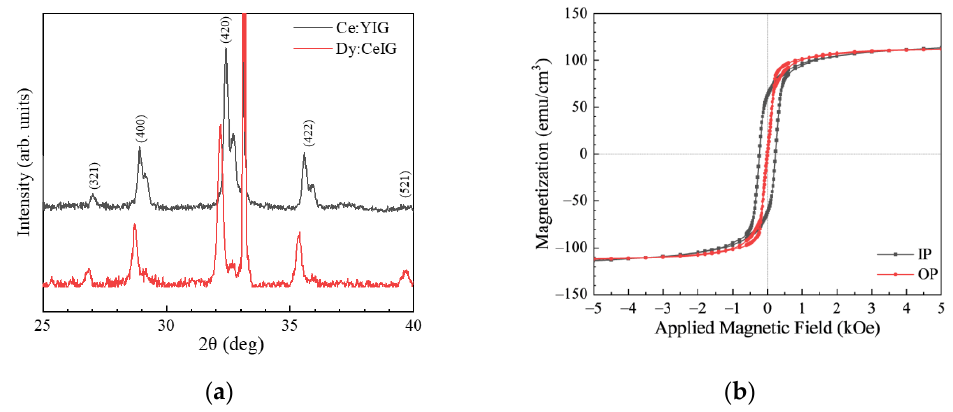
Figure 1. ( a ) X-ray diffraction patterns of Dy:CeIG and Ce:YIG thin films with a bottom yttrium iron garnet (YIG) seed layer of 50 nm in a 2θ range from 25° to 40°. ( b ) Room temperature in-plane and out-of-plane magnetization hysteresis loops for Dy:CeIG thin films.